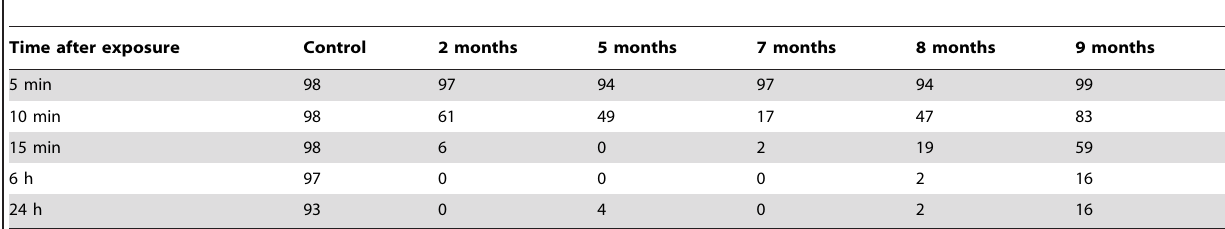
Table 3. Percentage of active Aedes aegypti following 10 seconds exposure to the treated net samples collected from the